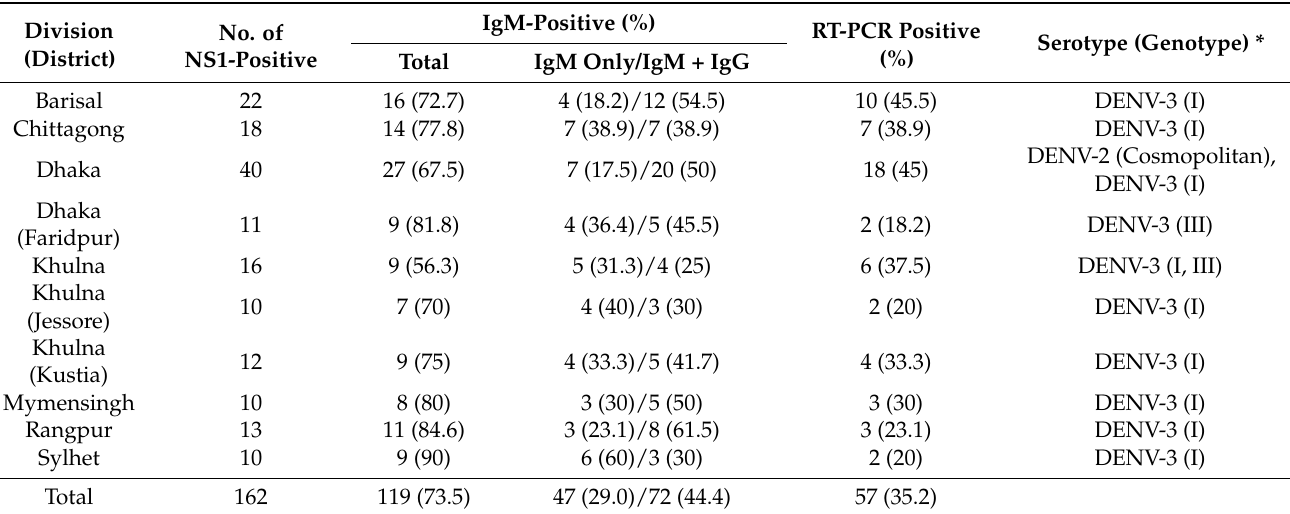
Table 1. Detection of DENV-specific antibody and C-prM gene, as well as assignment of DENV serotype/genotype, in individual divisions/districts.